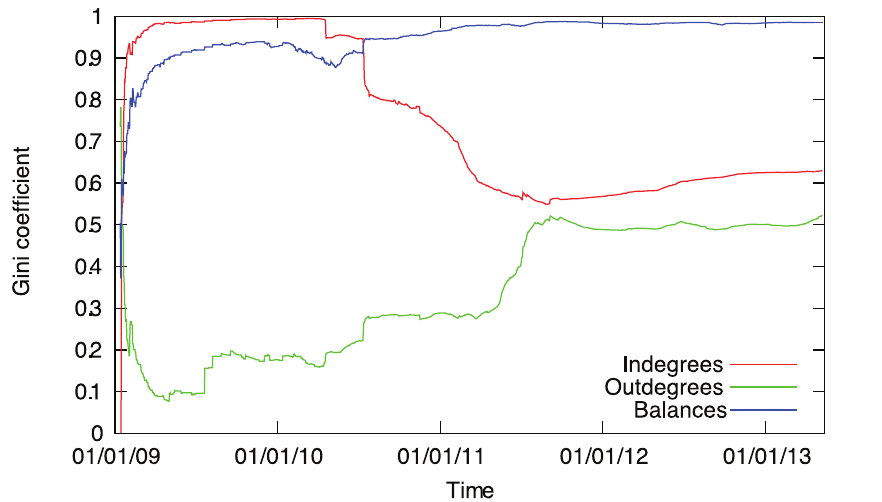
Figure 4. Evolution of the Gini coefficient of the degree and the balance distributions. We observe the distinct initial phase lasting until mid-2011. The trading phase is characterized by approximately constant coefficients.